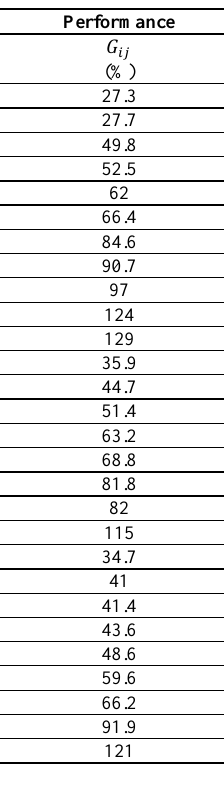
Table 16. Data of the components available in the market (Example 4). Subsystem